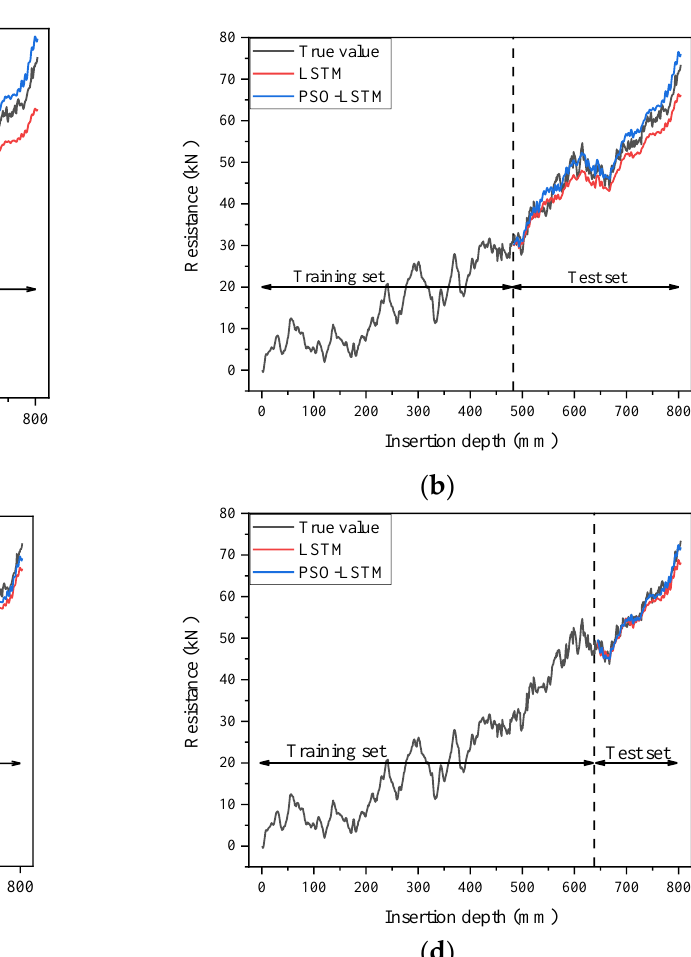
Figure 17. Gravel samples with an insertion depth of 600 mm. ( a ) The training set proportion of 50%; ( b ) The training set proportion of 60%; ( c ) The training set proportion of 70%; ( d ) The training set proportion of 80%.